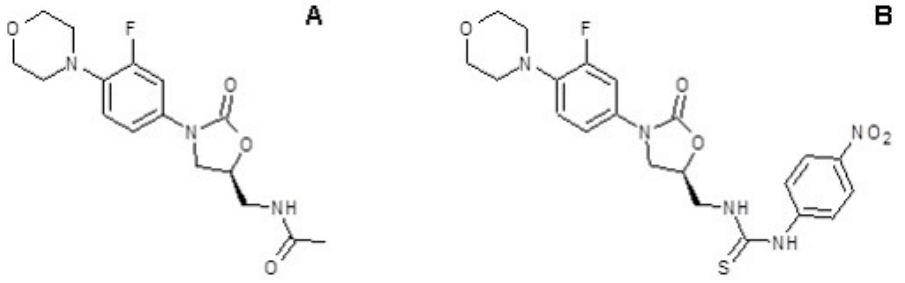
Figure 1. Chemical structures of linezolid and its analogue. Chemical structure of linezolid ( A ) and compound 10f ( B ).